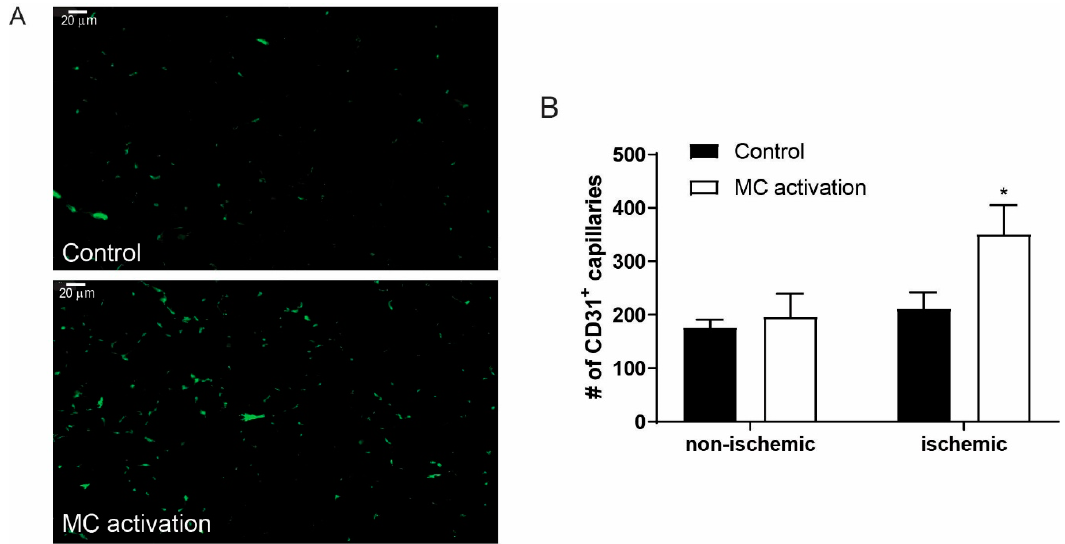
Figure 6. Activated mast cells induce angiogenesis in the ischemic hind limb. ( A ) CD31 staining of the ischemic soleus muscles shows the presence of CD31 + capillaries in control mice and in mice in which mast cells were activated. ( B ) Quantification of the number of CD31 + capillaries in non-ischemic and ischemic soleus muscle with (white bars) or without local (black bars) mast cell activation, measured at nine days after femoral artery ligation. * p < 0.05. nine days after femoral artery ligation. * p <